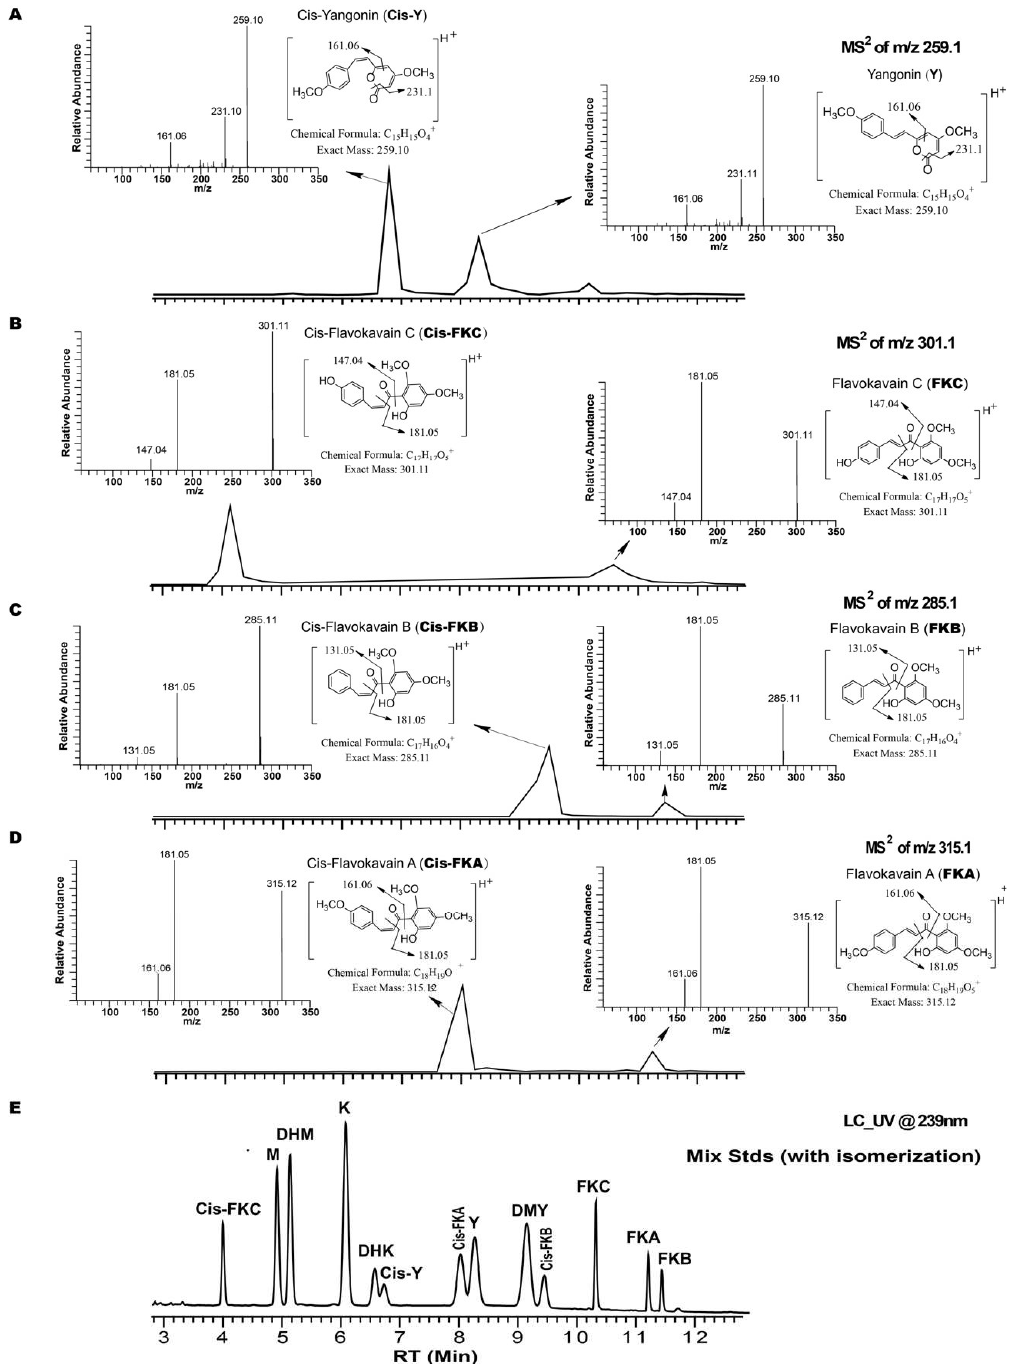
Figure 3. UHPLC-UV-MS data of degraded kava standard mixture, as follows: ( A ) MS/MS 2 trace of m / z 259.1, and MS 2 spectra of peaks of Y and cis-Y; ( B ) MS/MS 2 trace of m / z 301.1, and MS 2 spectra of peaks of FKC and cis-FKC; ( C ) MS/MS 2 trace of m / z 285.1, and MS 2 spectra of peaks of FKB and cis-FKB; ( D ) MS/MS 2 trace of m / z 315.1 and MS 2 spectra of peaks of FKA and cis-FKA; ( E ) UV trace at the wavelength of 239 nm; M, methysticin; DHM, 7,8-Dihydromethysticin; K, kavain; DHK, 7,8-Dihydrokavain; Y, Yangonin; Cis-Y, cis-yangonin; DMY, Desmethoxyyangonin; FKA (B or C), flavokavains A (B or C); cis-FKA (B, or C), flavokavains A (B or C).